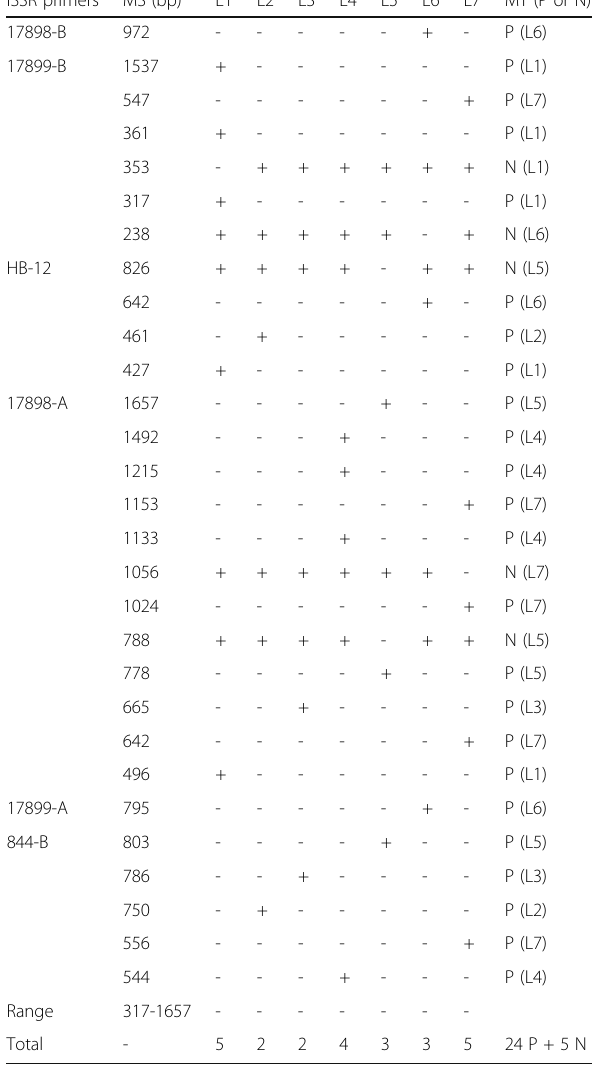
Table 17 Positive (P) and negative (N) specific markers of the seven rice entries using six ISSR primers ISSR primers MS (bp)